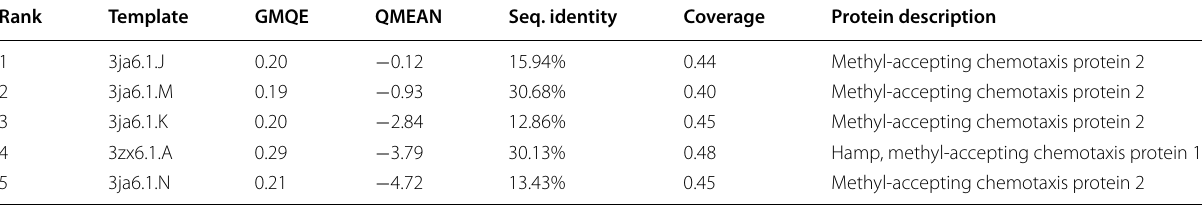
(1) GMQE (global model quality estimation) combines properties from the target-template alignment and the template structure, (2) QMEAN (qualitative model energy analysis) composed the major geometrical properties of protein structures